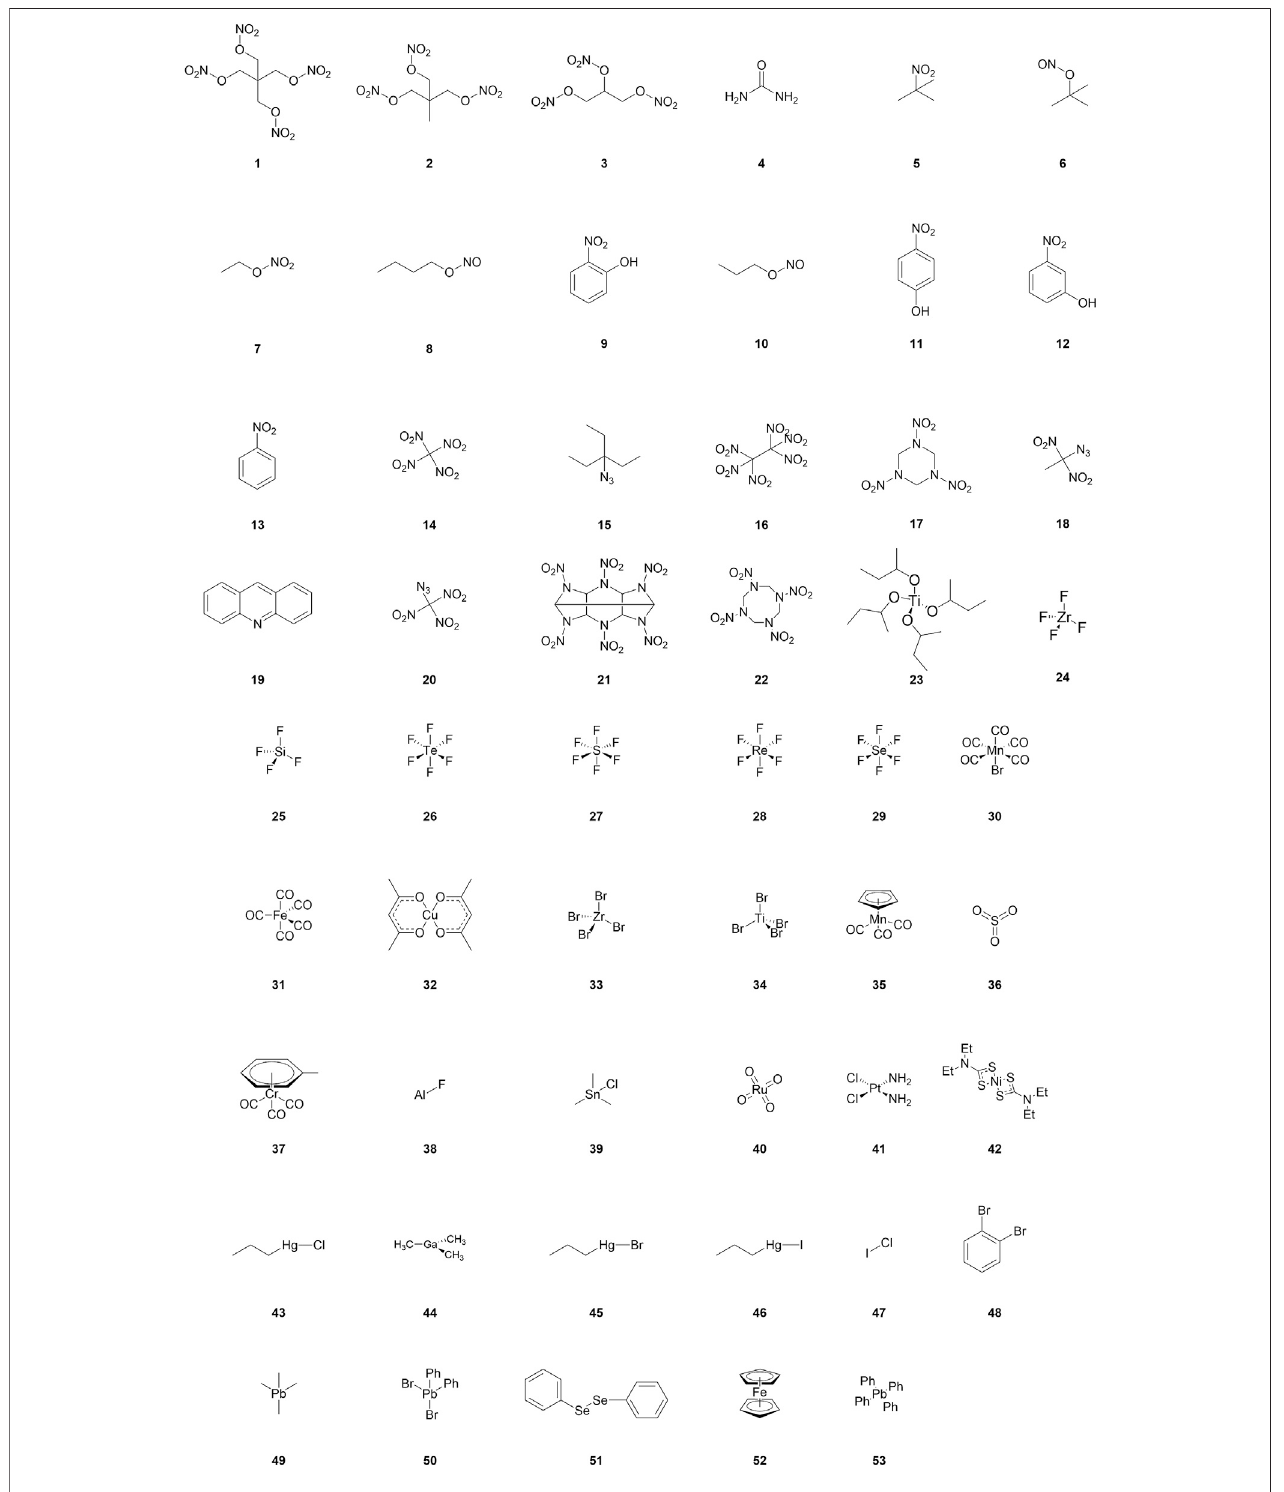
FIGURE 1 | Molecules, salts and co-crystals employed in heat of formation energy calculations.